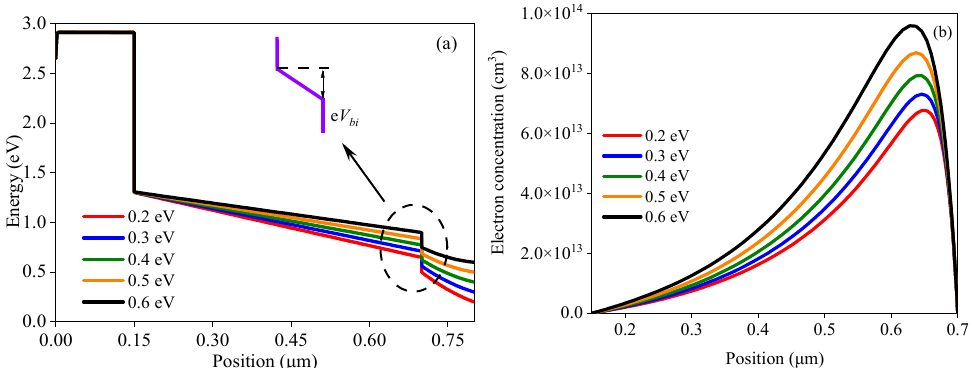
Figure 7. Effect of Φ on the solar cell: ( a ) J-V characteristic curves with different Φ values and ( b ) PCE with different Φ values.